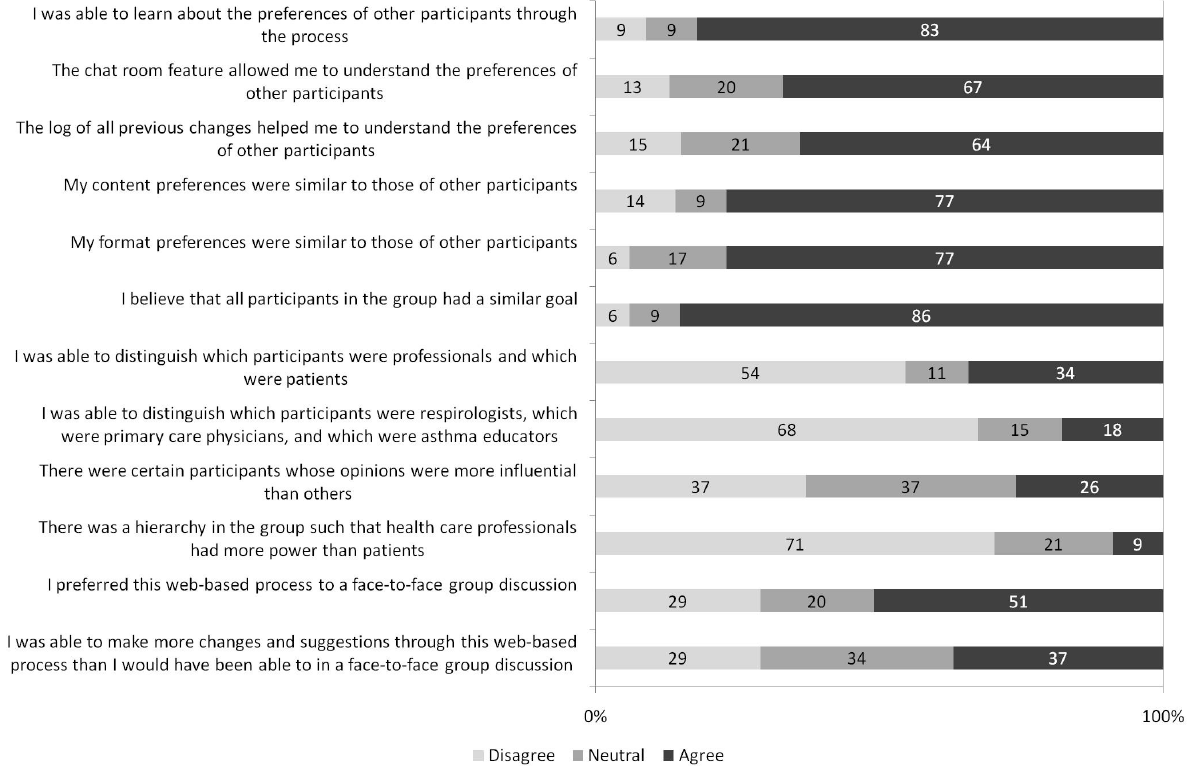
Figure 8. Participant interactions. Responses were entered on a 5-point Likert scale labeled as follows: 1, disagree; 3, neutral; and 5, agree. For the purposes of this figure, scores of 1 and 2 were considered “disagree,” and 4 and 5 were considered “agree.” Each bar demonstrates the proportion of participants with each response, for each statement. This includes 35 participants (5 certified asthma educators, 5 primary care physicians, 6 pulmonologists, and 19 patients with